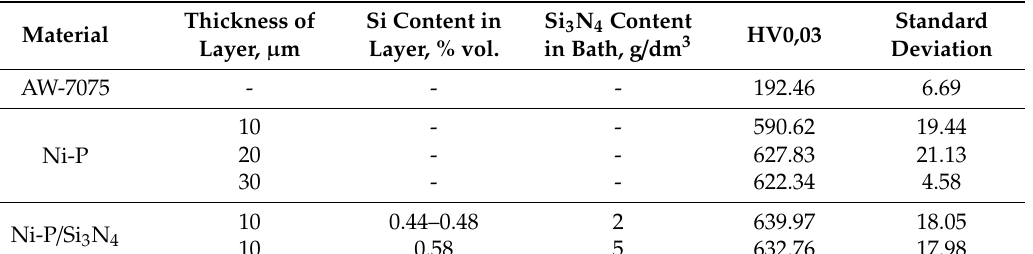
Table 7. Microhardness of layers.